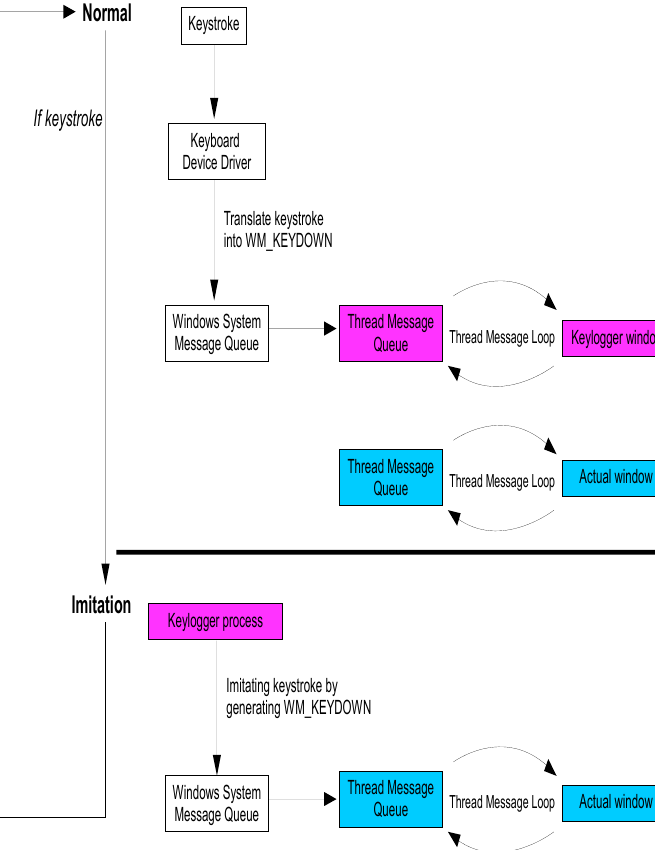
Figure 5. Manipulation of keystroke processing in Windows by Mouse